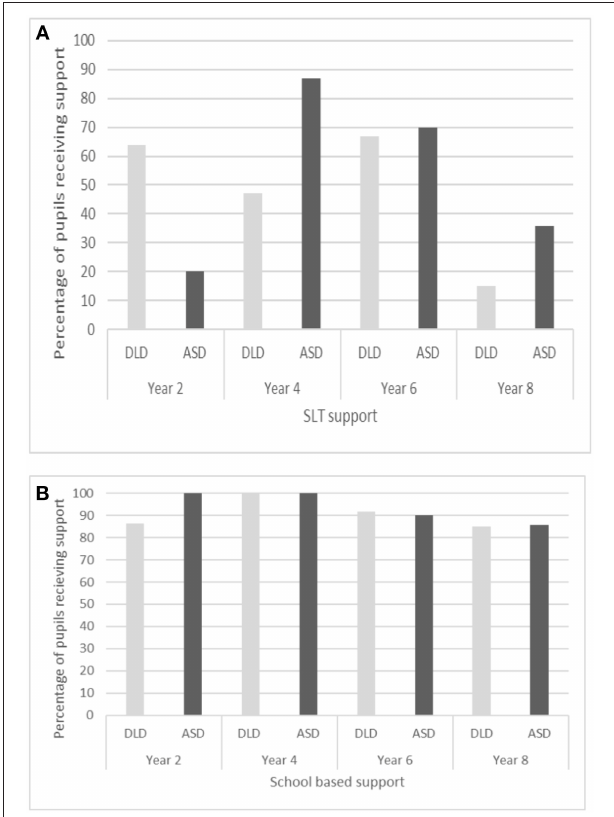
FIGURE 2 | (A) Distribution of support by year group provided by SLTs for the children with DLD or ASD. (B) . Distribution of support by year group provided by schools for the children with DLD or ASD. SLT, speech and language therapist.